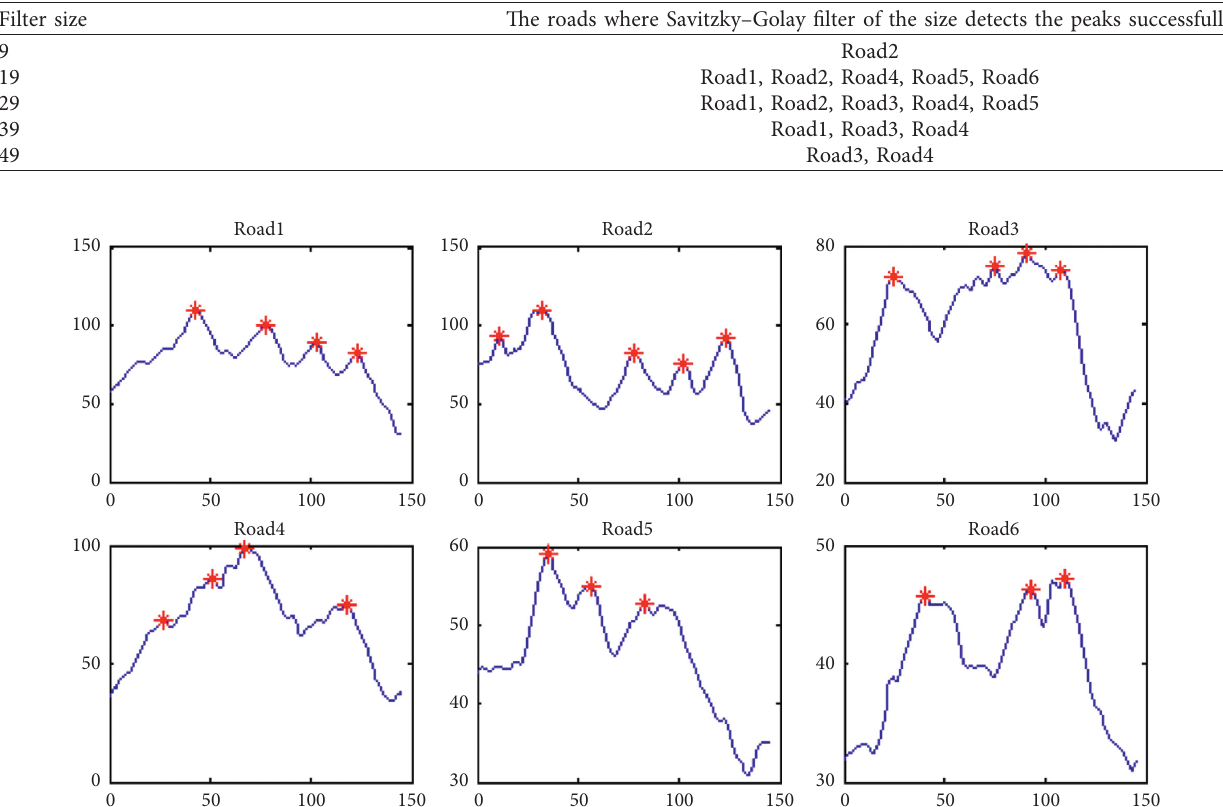
Table 3: The results of Savitzky–Golay filter of different sizes.